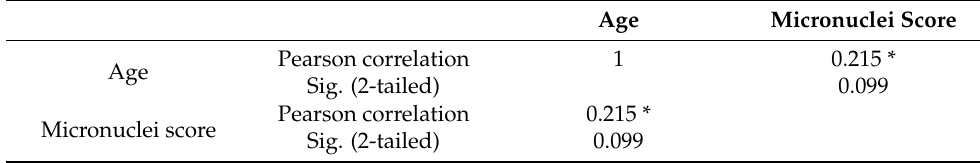
Table 4. Correlation between age and micronuclei score.